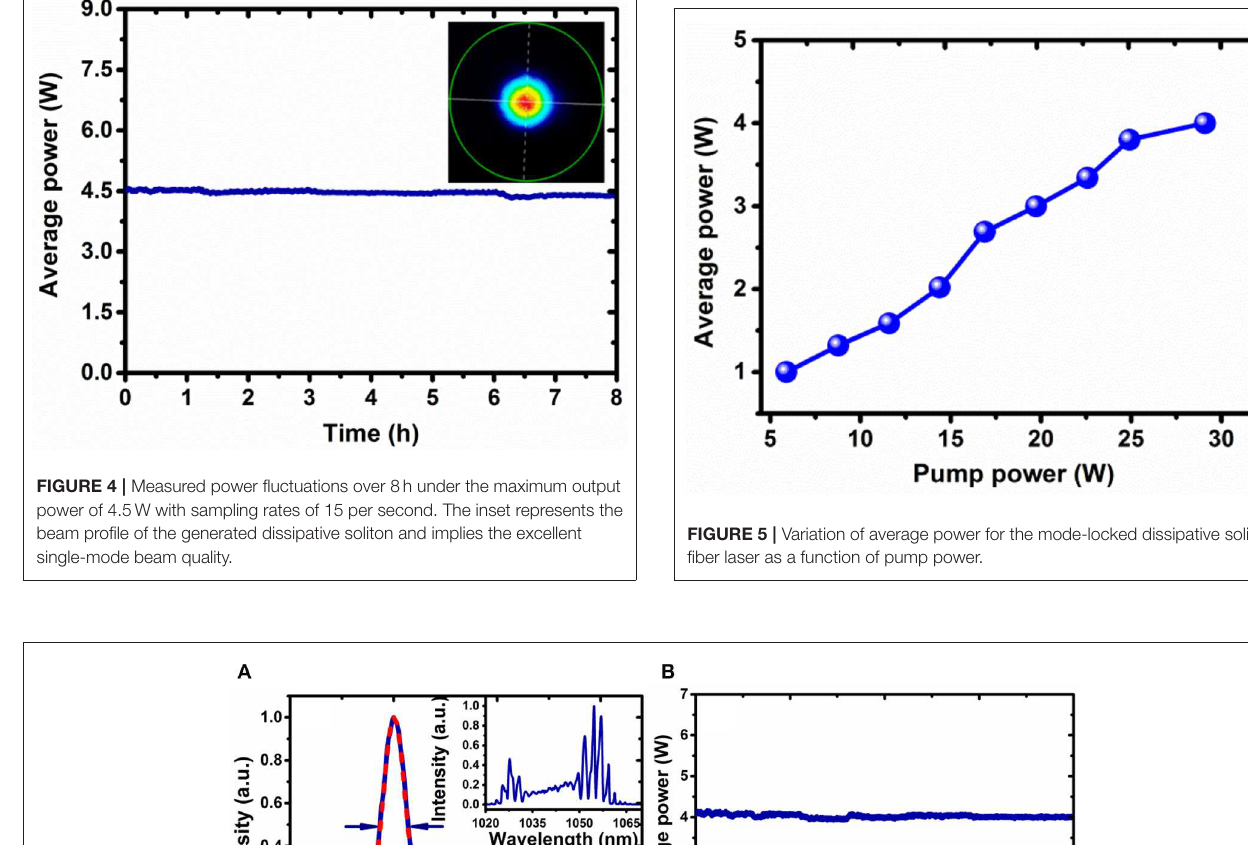
Frontiers in Physics |